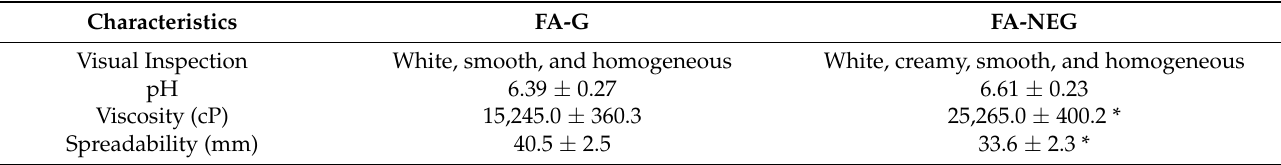
Table 4. Characterization of optimized FA-G and